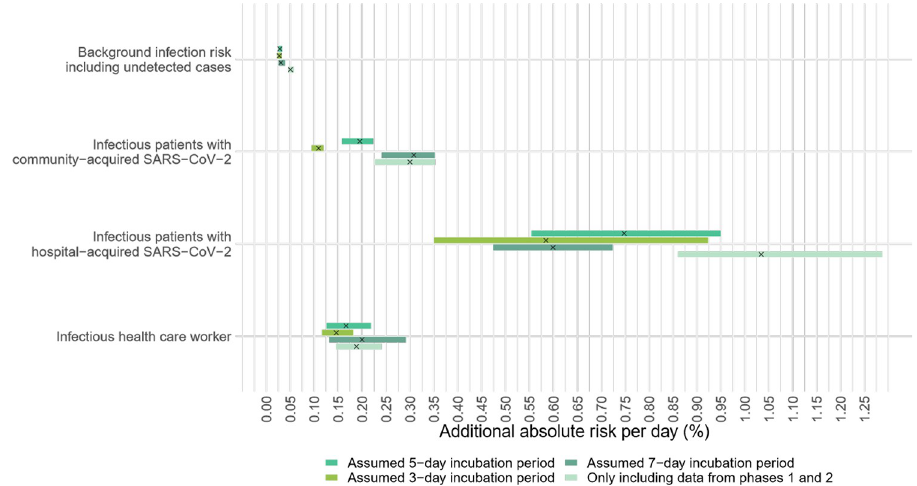
Fig 4. Additional risk of suspected nosocomial acquisition of SARS-CoV-2 experienced by a single susceptible patient contributed by (i) infectious patients who acquired SARS-CoV-2 in the community (second row); (ii) infectious patients who acquired SARS-CoV-2 in the hospital (third row); and (iii) infectious HCWs (last row). A generalised mixed model with an identity link was used, with assumed nosocomial acquisition (yes/no) on each day as the dependent variable. Both the intercepts and slopes were allowed to vary by ward. The top row shows the variation of the intercepts of the model, which represent the background infection risk posed by infectious patients and HCWs who are undetected. Each horizontal bar represents the 95% CrI of the estimate. The black crosses in the centre of each bar represent the median of the estimates. CrI, credible interval; HCW, healthcare worker; SARS-CoV-2, Severe Acute Respiratory Syndrome Coronavirus